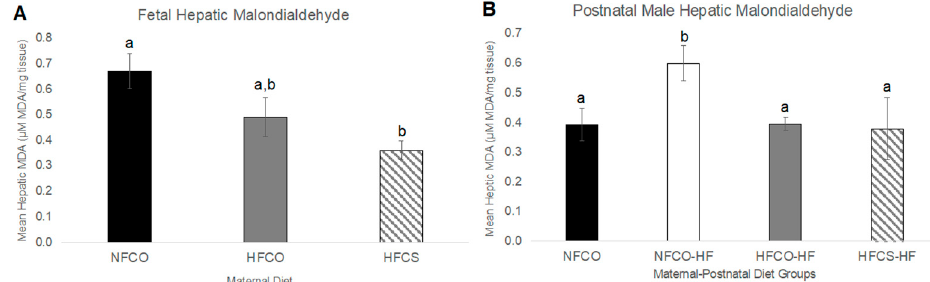
Figure 2. Hepatic lipoxidation in fetal and postnatal offspring livers. ( A ) E17.5 fetal liver lipoxidation measured with malondialdehyde (MDA) levels; ( B ) Male offspring liver lipoxidation after 6-week post-weaning HF feeding. Dams were fed NF or HF diets with or without CS prior to and during pregnancy. n = 6–10/group; values represent means ± SEM. a,b, different letters indicate significant differences between groups ( p < 0.05) analyzed with ANOVA and Post-hoc Fisher’s LSD; any two groups with no overlapping letters demonstrated significant difference in their pair-wise comparison; CO, untreated control without choline supplement; CS, choline-supplemented; HF, high-fat; MDA, malondialdehyde; NF, normal-fat.